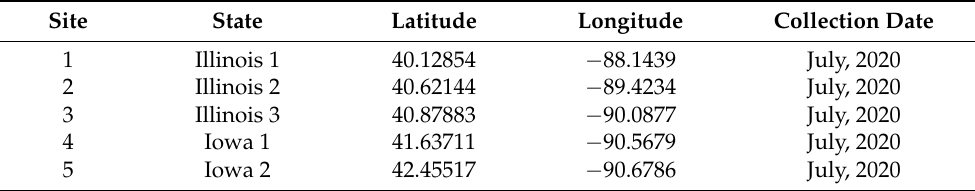
Table 1. Sampling locations and GPS information for Depressaria depressana collected from wild carrot ( Daucus carota ) for this